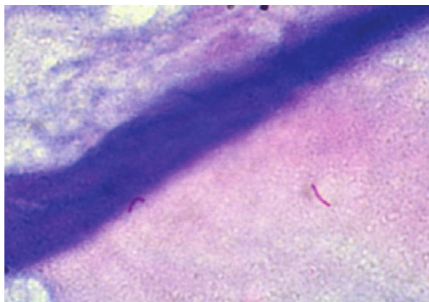
Figure 3: Z-N staining showing acid fast bacilli (X100; in oil immersion